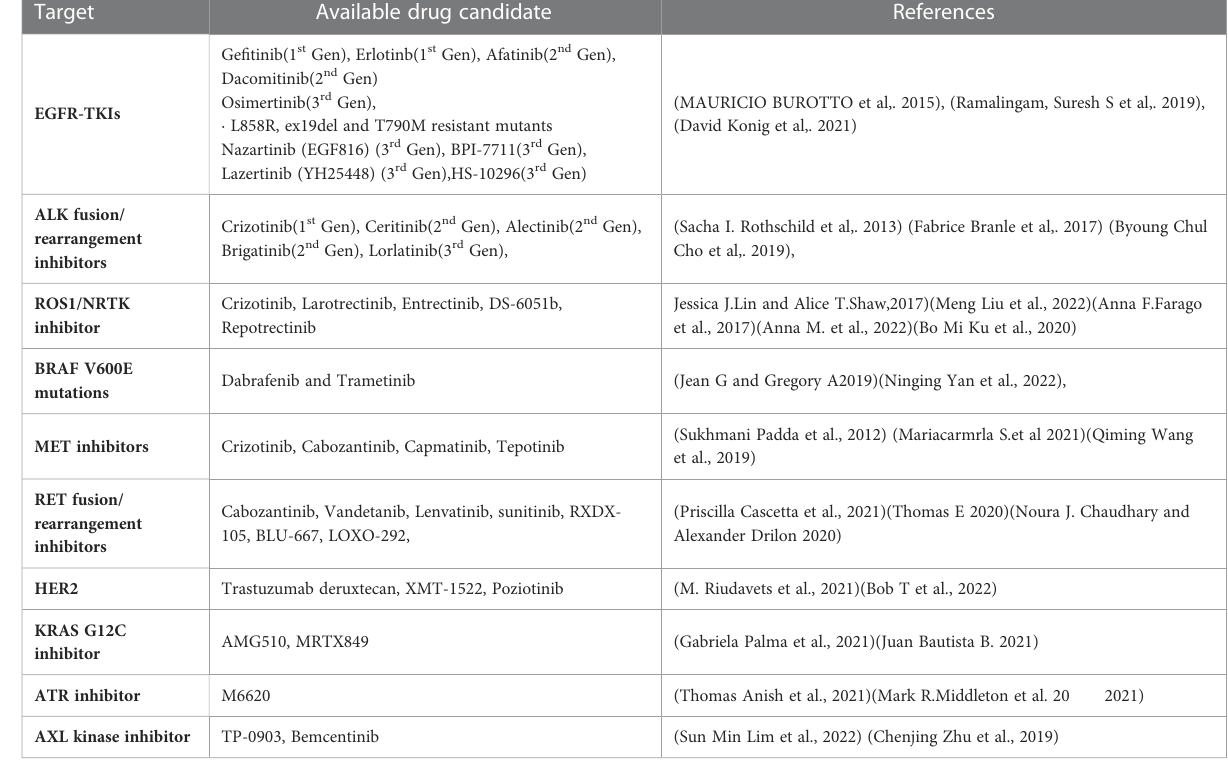
TABLE 1 Available targeted therapies. Target Available drug